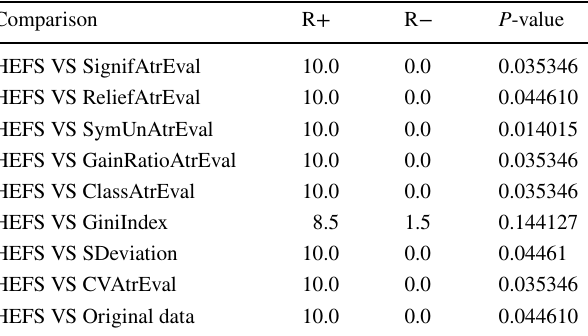
Table 6 The result of Wilcoxon statistical significance test with a sig- nificance threshold of 𝛼 = P -values